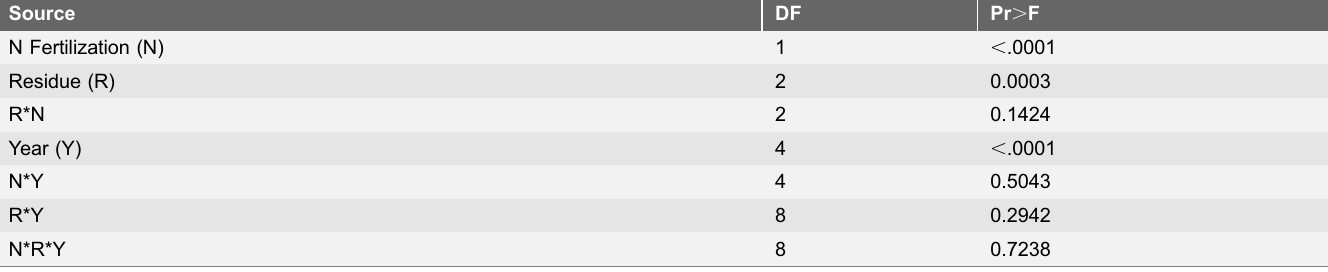
Table 3. Analysis of variance for biomass yield as affected by N fertilization, residue return, and their interaction in 2008, 2009, 2010, 2011, and